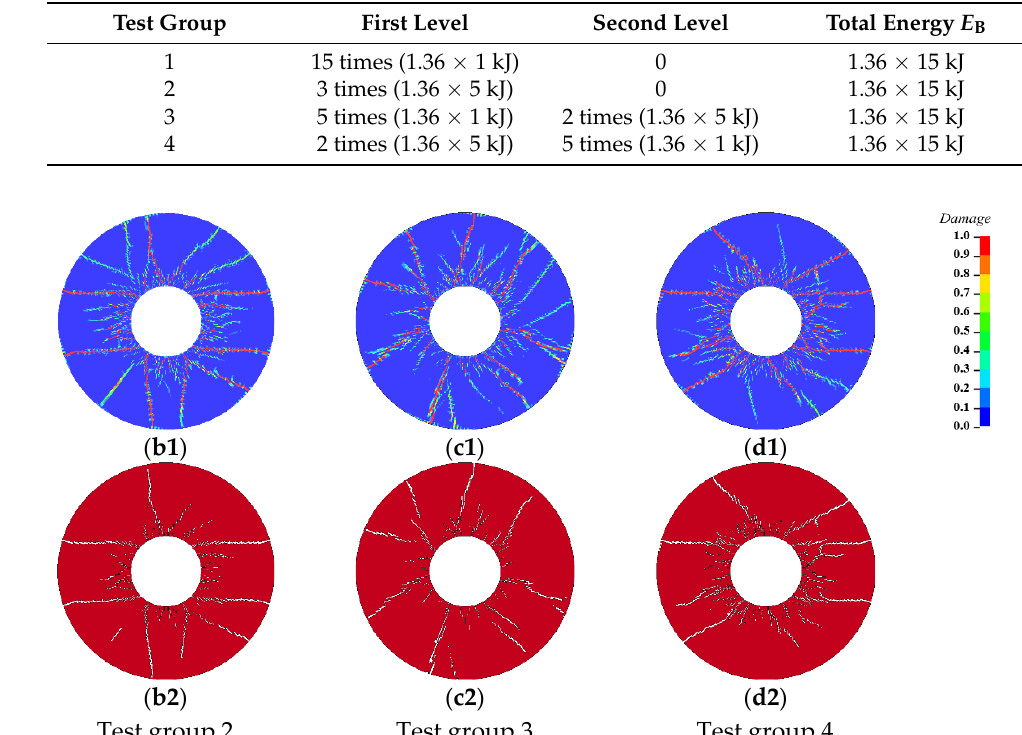
Figure 18. Damage distribution ( a1 , b1 , c1 , d1 ) and crack pattern ( a2 , b2 , c2 , d2 ) under different dis- charge